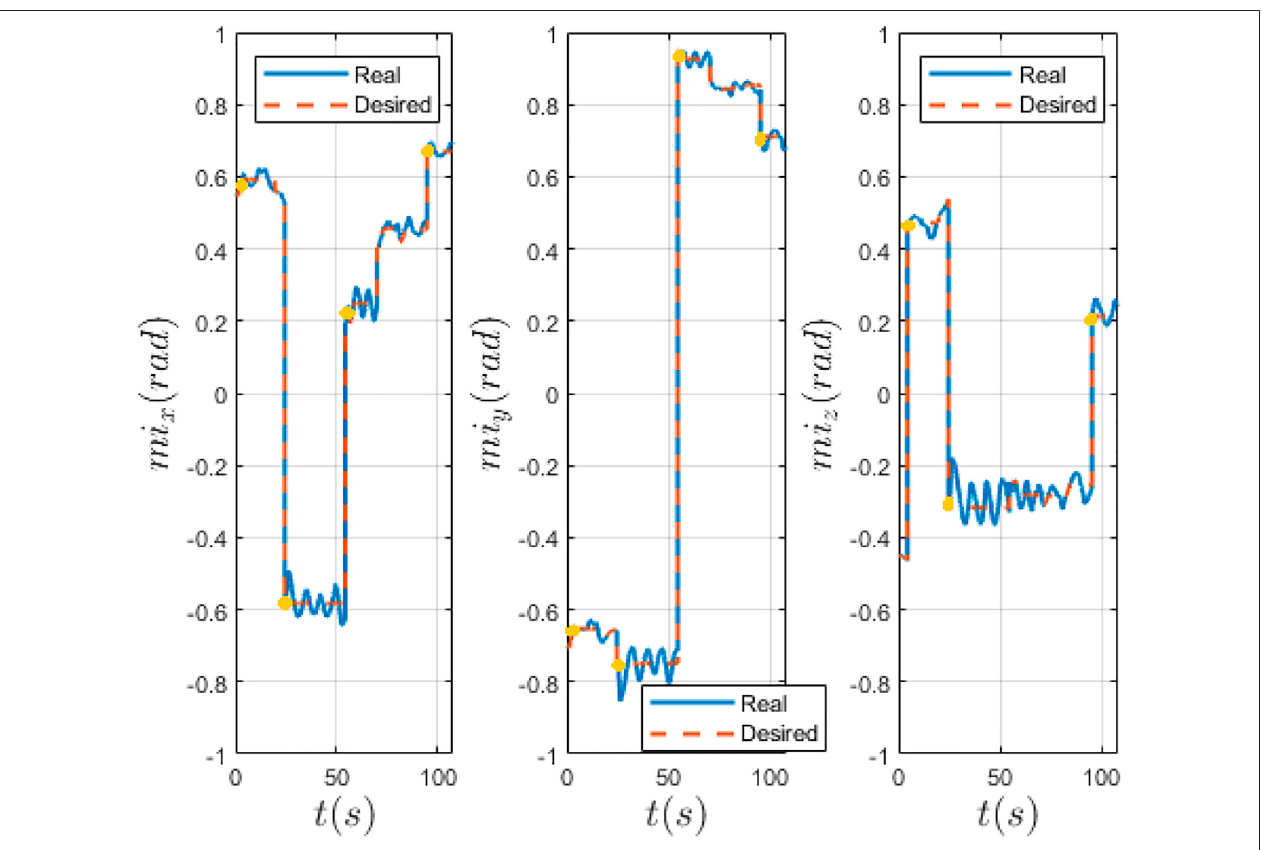
FIGURE 9 | Real and desired IPM magnetic moment computed with PID controller. Desired (red) and real (blue) magnetic moment of the IPM in world frame. The yellow dots indicate the moment when the biopsy forceps is being introduced in the instrument port.